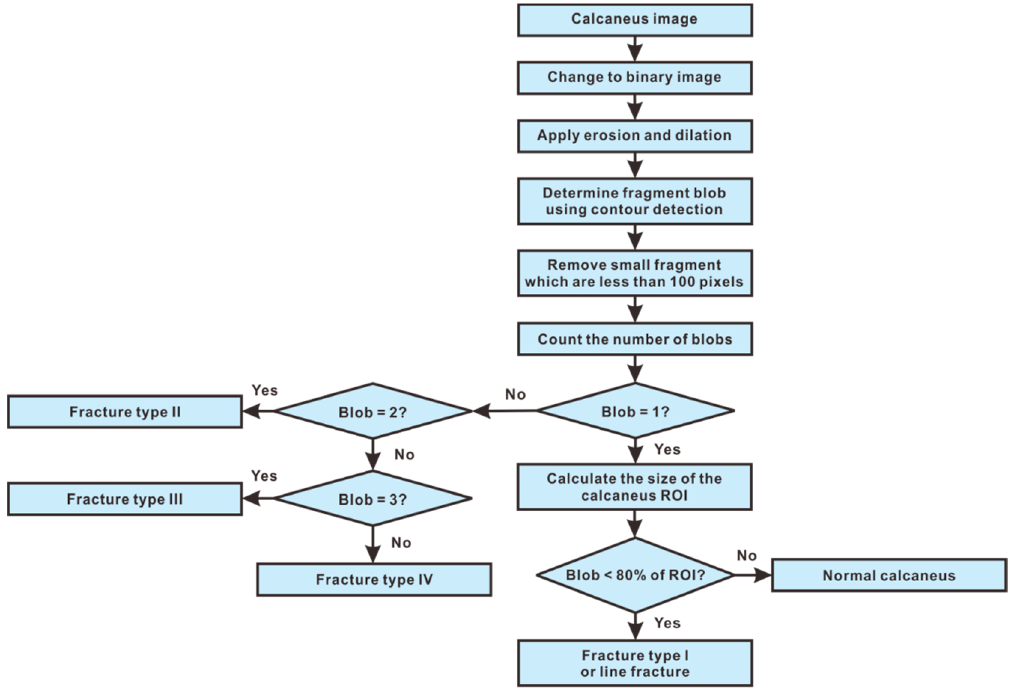
Figure 8. Algorithm for determining the type of calcaneus fracture in the coronal and transverse image.